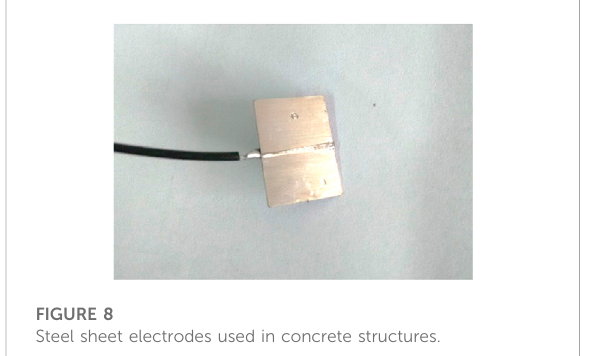
FIGURE 8 Steel sheet electrodes used in concrete structures.